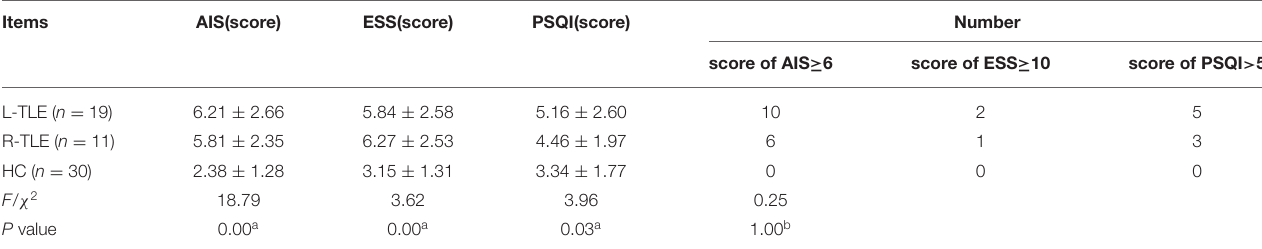
TABLE 2 | The score of self-evaluation sleep questionnaire in subjects of the study. Items